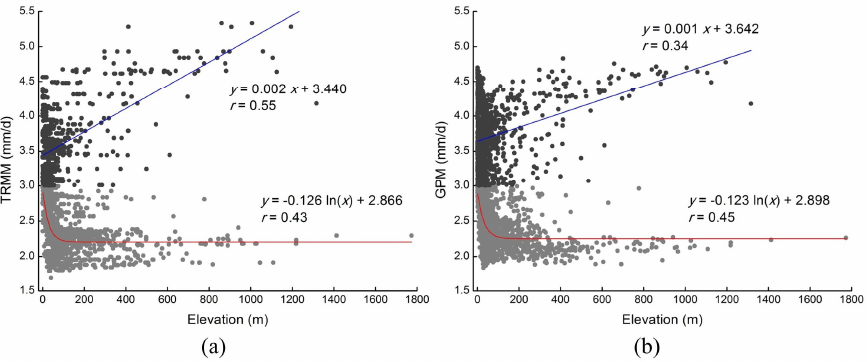
Figure 11. Scatterplots of mean daily precipitation of TRMM 3B42 v7 (a) and GPM IMERG v5 (b) precipitation products against the elevation over the Huaihe River basin.